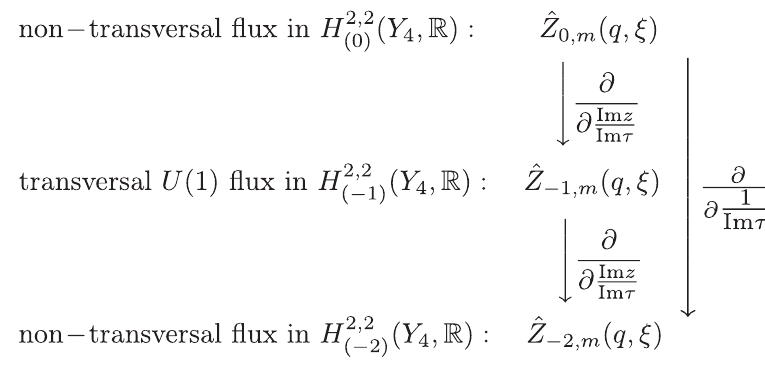
, which can, at least 3